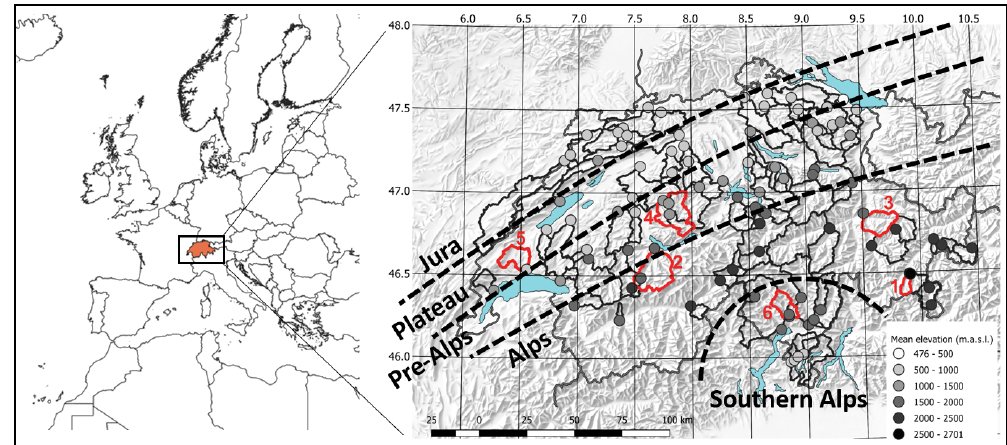
Figure 1. Overview of the study region and the location of the gauging stations in Switzerland. Shading indicates the mean elevation of the respective catchment. Red contours indicate the six example catchments: Rosegbach–Pontresina (1), Kander–Hondrich (2), Plessur–Chur (3), Emme–Emmenmatt (4), Venoge–Ecublens (5), and Verzasca–Lavertezzo